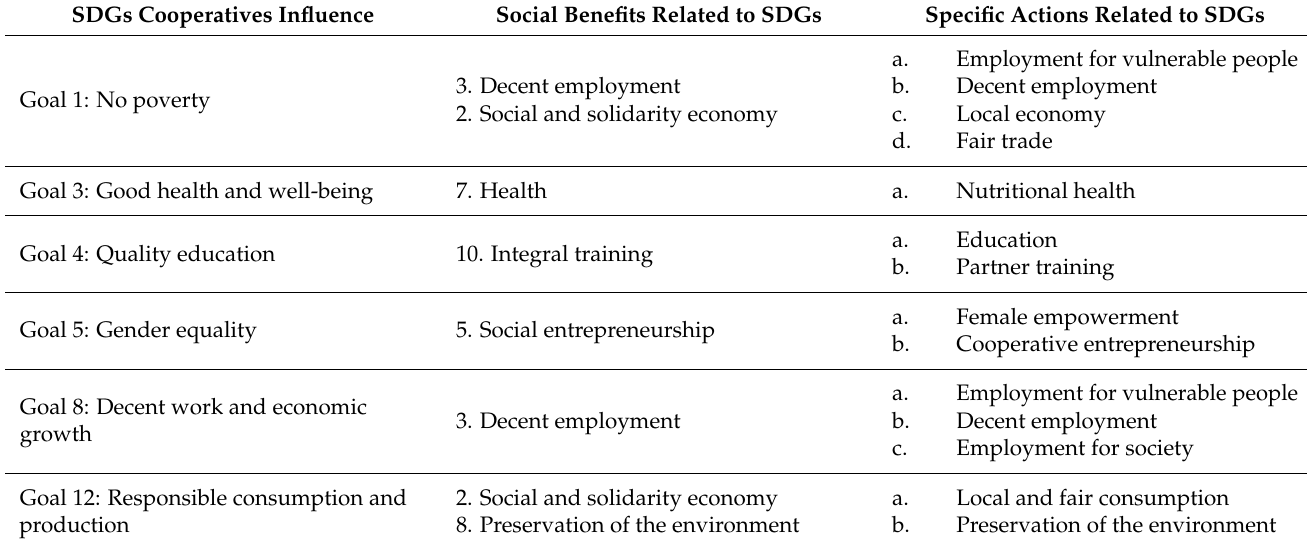
Table 3. Alignment between the SDGs and the benefits of cooperatives in Mexico